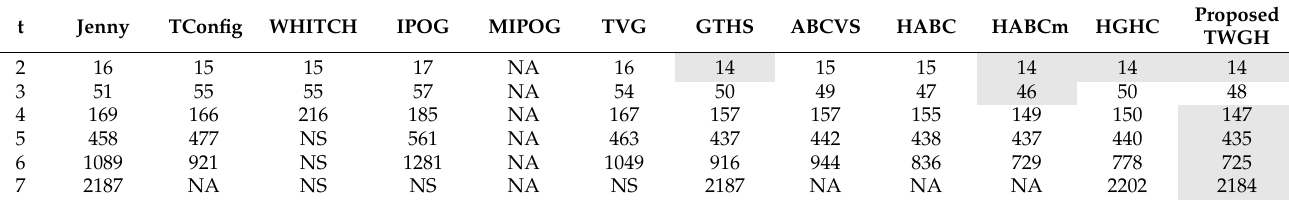
Table 3. CA (N; t, 7, 3) with t between 2 and 7.